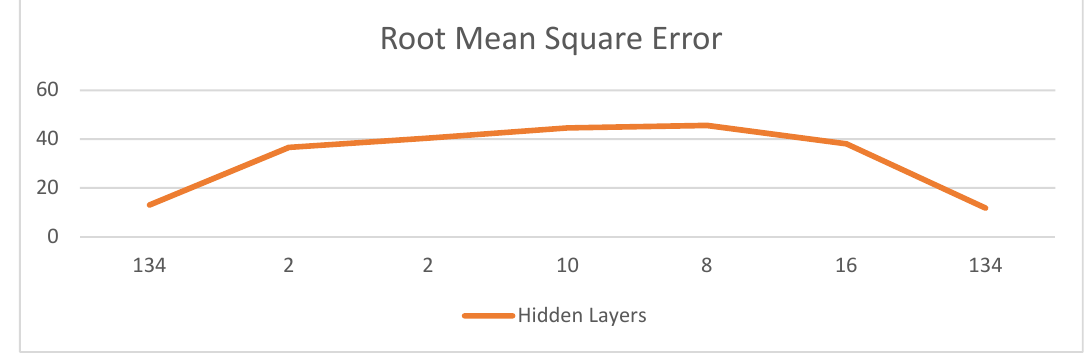
Figure 5. The root mean square error.